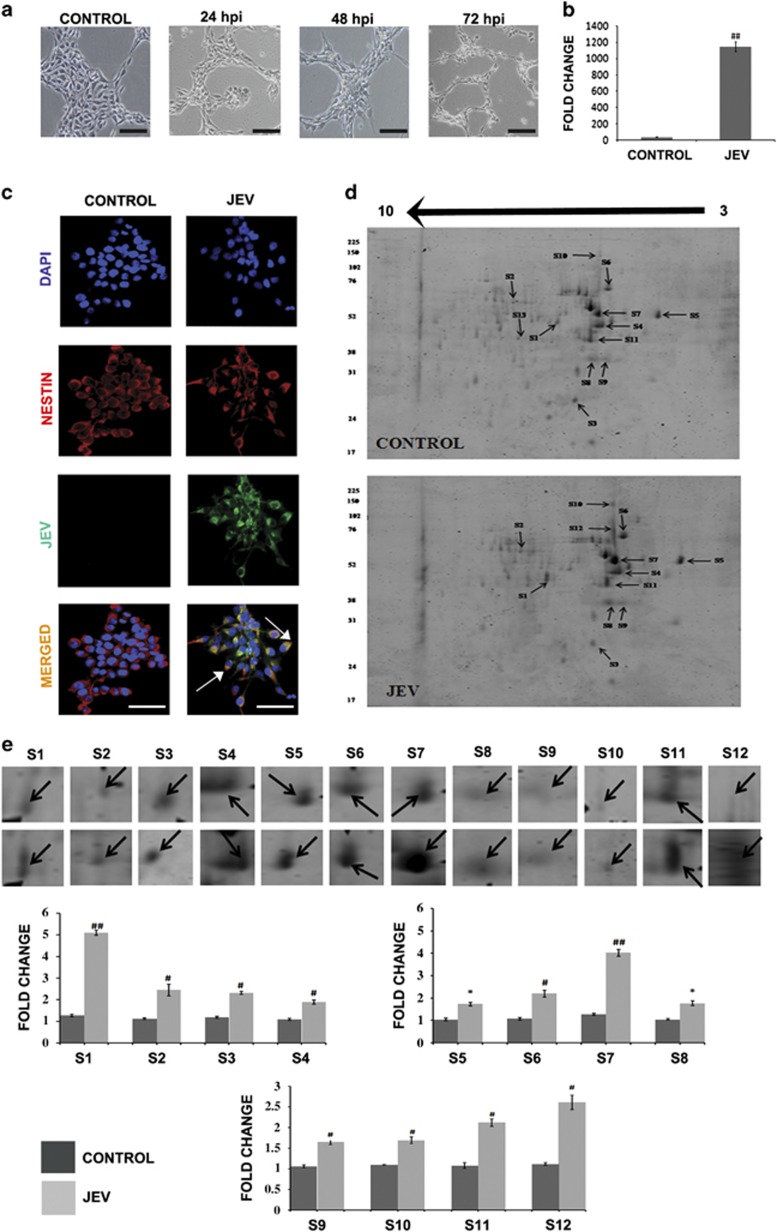
JEV propagates in hNS1 cells mediating proteomic alterations. (a) JEV-mediated cytopathic changes were observed in hNS1 cells at different time points of infection (scale bar –50 μm). (b) Confirmation of infection was done by real-time PCR at 72 h post infection and significant changes were observed in viral load. (c) Immunostaining images also represent JEV infection in all Nestin positive cells (scale bar –20 μm). (d) Equal amount of proteins from uninfected and JEV infected hNS1 cells were separated by IPG strips of pH 3–10 (first dimension) and then on 12% SDS-PAGE (second dimension) in which 13 spots were found to be differentially expressed upon viral infection. The spots are labelled in gel image according to Table 1. These spots were marked, excised and identified by MALDI-TOF. (e) Bar graphs show relative fold change of the differentially expressed spots (only the spots having fold change ratio |JEV/Control|>=1.5 were taken into consideration). Spot intensities were normalized according to their mean values obtained from duplicate analytical gels after t-test analysis (*P<0.05, #P<0.01, ##P<0.001). Data are representative of three independent experiments (mean±S.D.). IPG, immobilized pH gradient